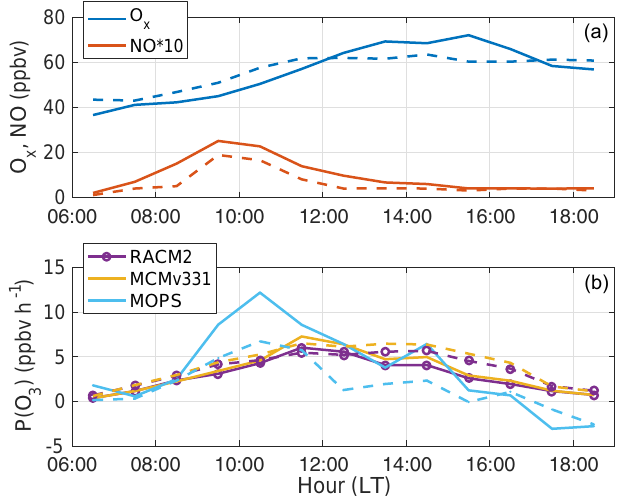
Figure 7. (a) O x (O 3 + NO 2 ) and NO mixing ratios for Denver plume (solid) versus all other days (dashed) from 17 July to 10 Au- gust 2014 in Golden, CO. (b) Median measured and modeled P(O 3 ) for Denver plume (solid) and non-Denver plume (dashed) days be- tween 06:00 and